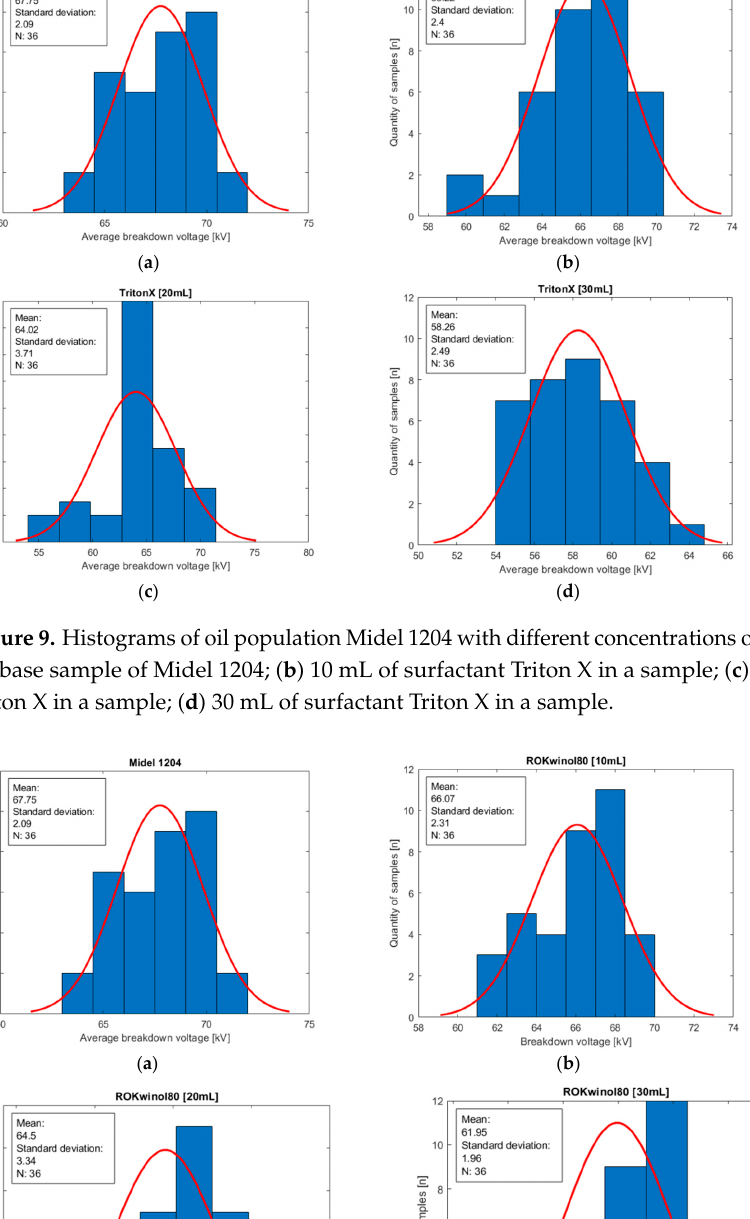
( d ) Figure 11. Histograms of oil population Midel 1204 with different concentrations of surfactant oleic acid: ( a ) base sample of Midel 1204 ; ( b ) 10 mL of surfactant oleic acid in a sample; ( c ) 20 mL of sur- factant oleic acid in a sample; ( d ) 30 mL of surfactant oleic acid in a sample. In the next chapter, the authors discuss hypothetical tests to fit the correct distribu- tion of the population. Box plots for the Triton X (Figure 12), the ROKwinol80 (Figure 13), and the oleic acid (Figure 14) were made, from which we can read basic statistical data. Graphically, they